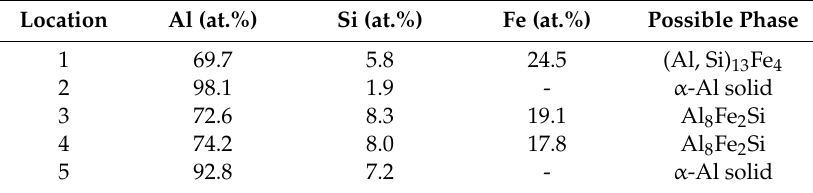
Figure 9. Fracture path, fractography and XRD analysis results of steel side of tensile specimens with various welding conditions: ( a – d ) 0 A, 0 Hz; ( e – h ) 2 A, 0 Hz. Table 4. EDS spot scanning results of zones 1–5 in Figure 9.